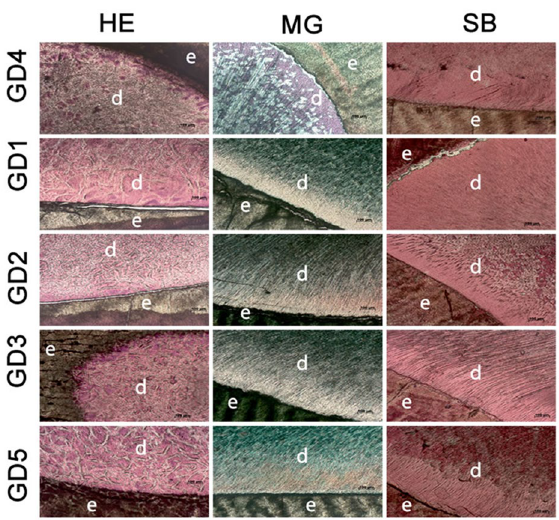
Figure 4. Histology analysis (inverted optical microscopy at AXIOVERT 40C using Axio Vision software)— structural modifications were not identified, although presented a variation on population, in special on GD1, GD2 and GD3 of colorants HE and MG; letter “d” represents dentine, and “e” enamel region. The software used to plot the images was Origin